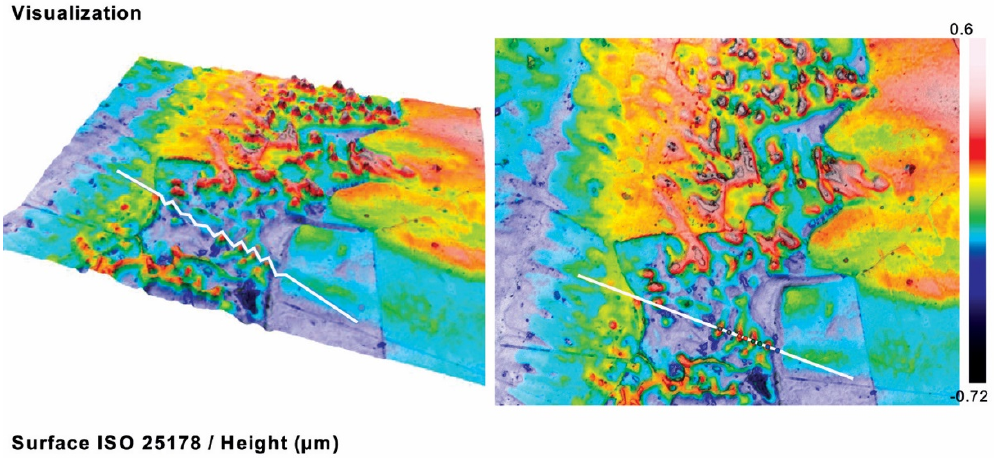
Figure 16. Test results of profile analysis for the zone of 304L austenitic stainless steel. The analysis was performed along the white line.